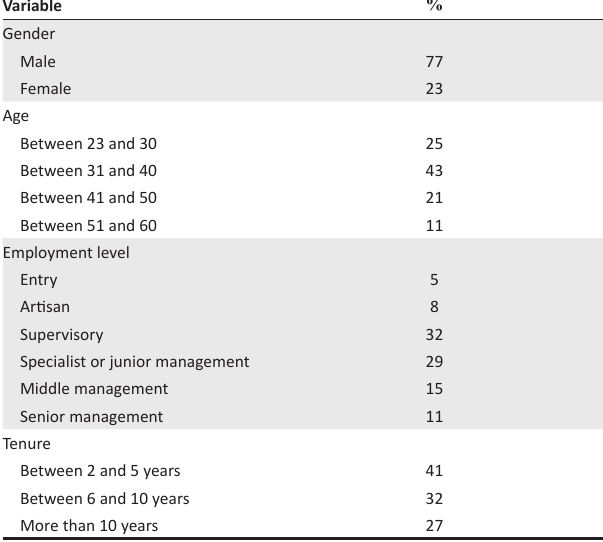
TABLE 1: Demographic profile of